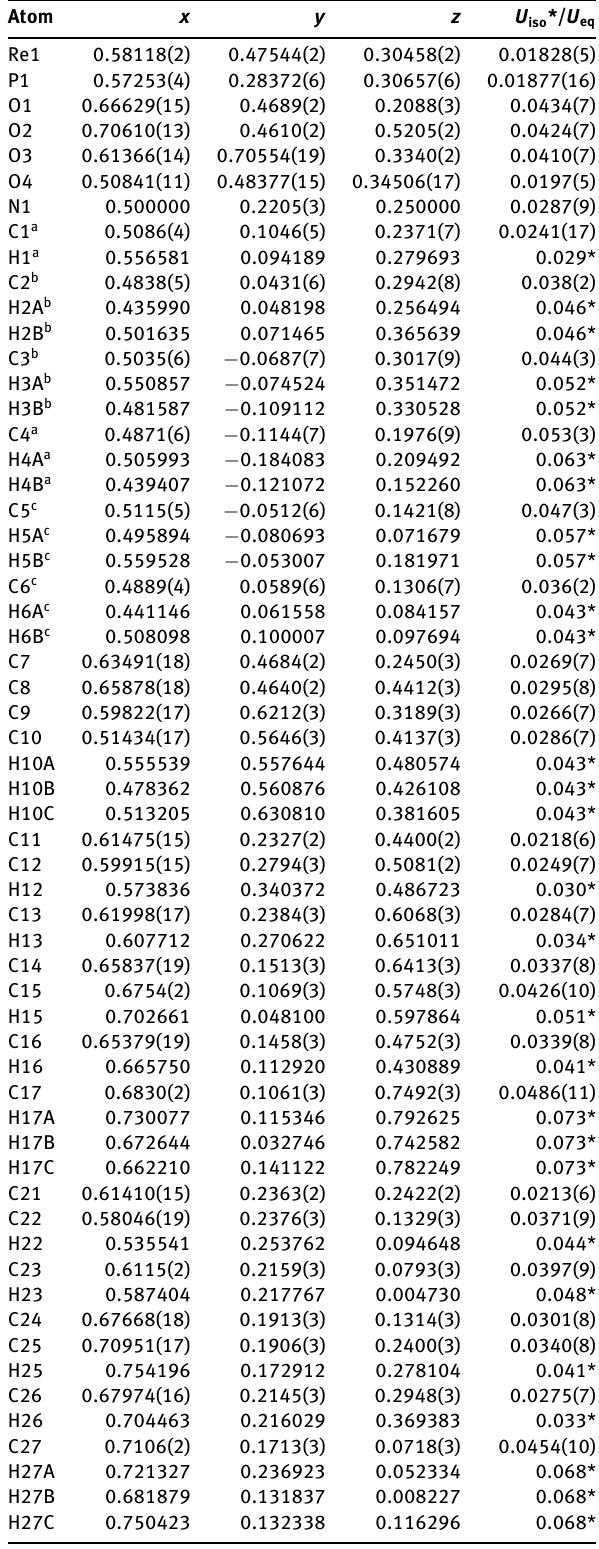
Table 2: Fractional atomic coordinates and isotropic or equivalent isotropic displacement parameters (Å 2